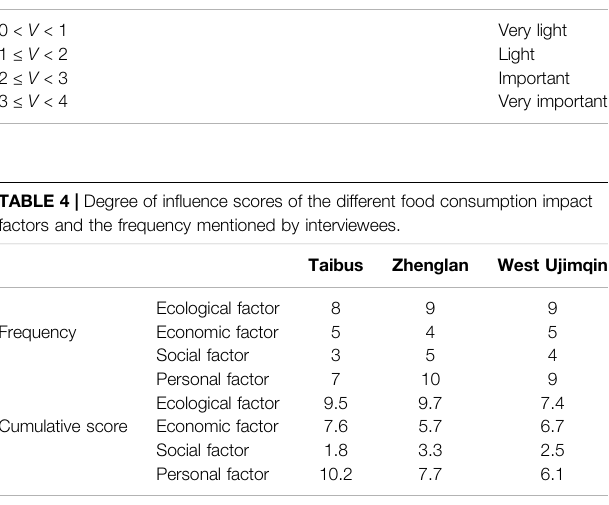
TABLE 3 | Grading of the effect degree in fuzzy cognitive map (FCM) results. Source Range